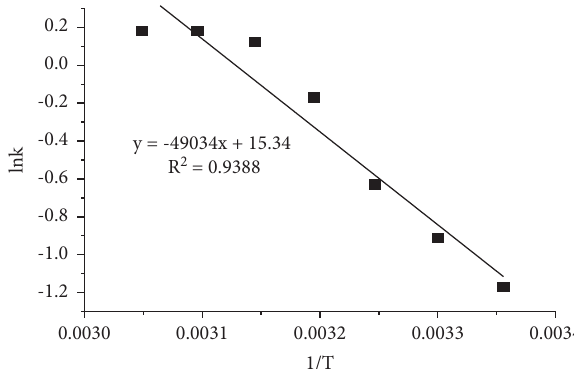
Figure 16: Termodynamics of the adsorption of fuoride ions onto bone char.